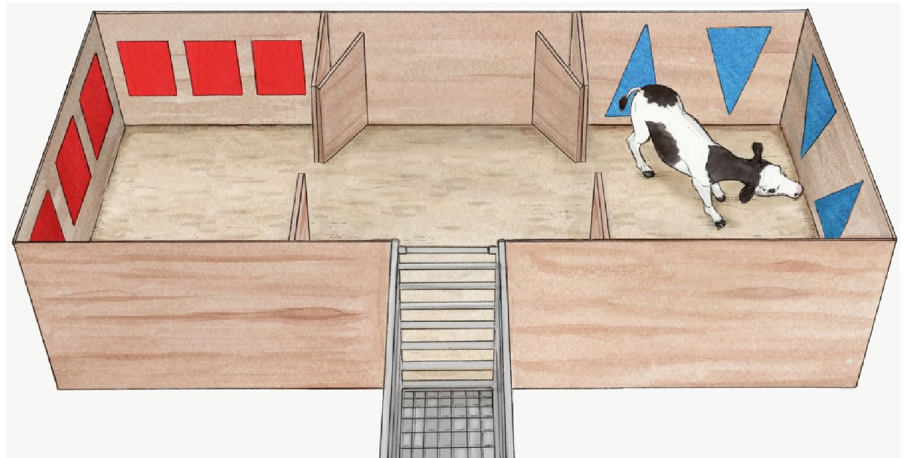
Figure 3. Conditioned place aversion apparatus. Each calf received and recovered from two different disbudding procedures in the treatment pens (side pens with visual cues on walls). After receiving both treatments, they were tested for place aversion by letting them roam between the pens. Illustration by Ann